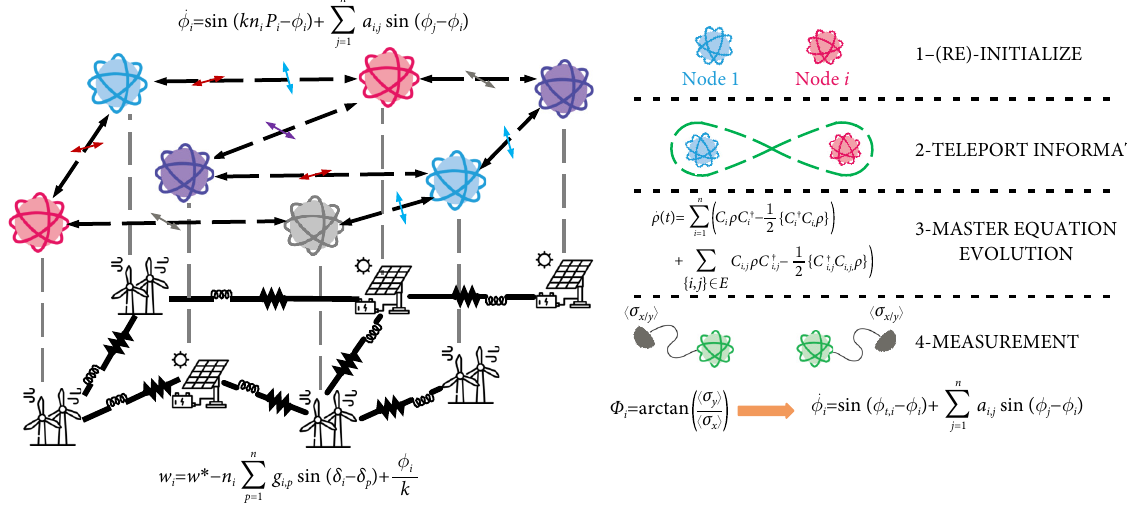
Fig. 7 Coupling of power grids to the network of quantum controllers (left), and schematic depiction of the QDC algorithm (right) [22]